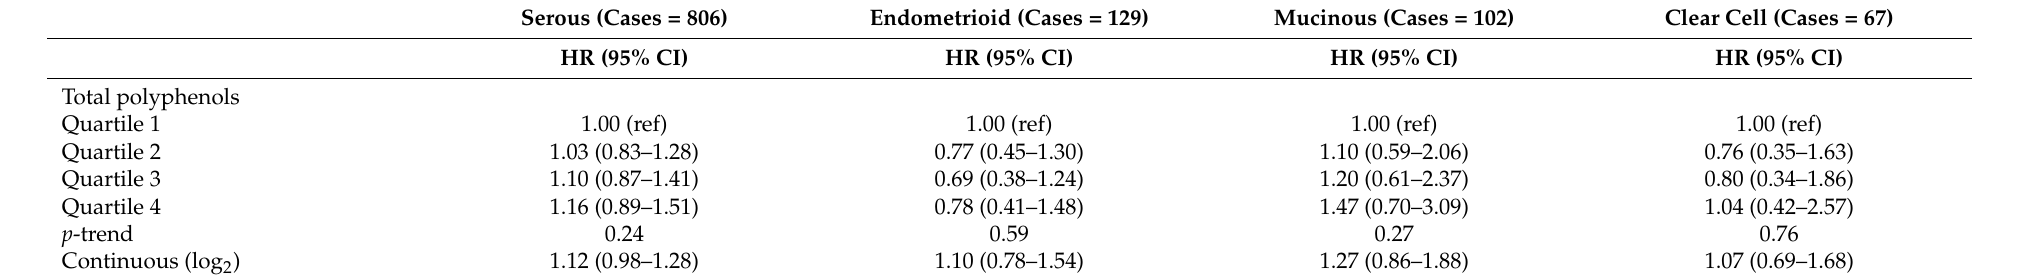
Table 3. Hazard ratios and 95% confidence intervals for histological subtypes of epithelial ovarian cancer, according to quartile of intake of total polyphenols, flavonoids and phenolic acids in the EPIC